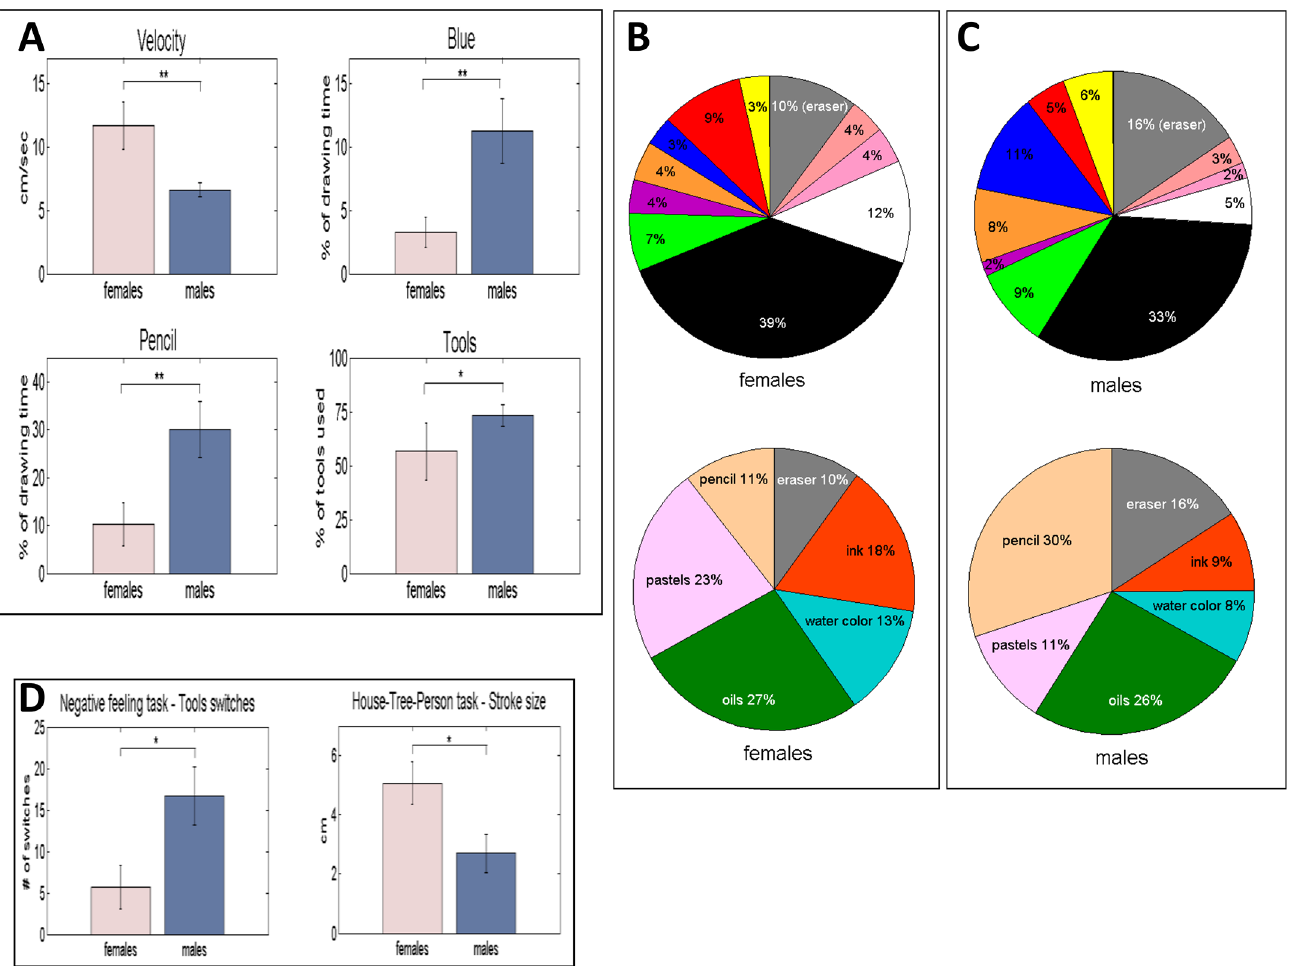
Fig 12. Depiction of gender difference. ( A ) Depiction of statistically significant mean differences in the gender study of the artworks. These have emerged for the mean drawing velocity, averaged over all artworks of males and females ( n = 48), for mean percentage of time use of the blue color and of the pencil ( n = 36), and for the mean number of tools used by both genders, depicted here as the percentage of total tools ( n = 36). ( B ) The color and tool use of females, displayed as the percentage of drawing time. ( C ) The color and tool use of males. ( D ) Gender significance examples within specific drawing tasks. Mean difference in the number of tool switches has emerged for males and females imaging negative feeling. The artworks in the house-tree-person drawing task yielded mean differences in the average stroke size ( n = 12). Data are reported as the mean ± SEM. * p < 0.05, ** p <